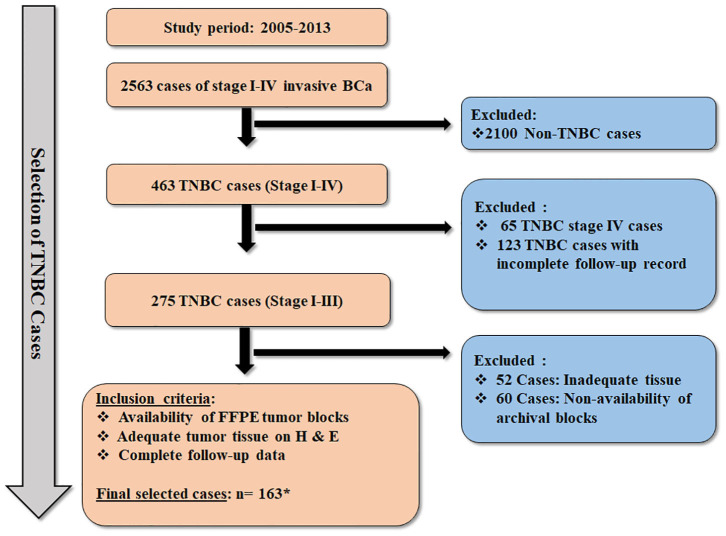
Flow diagram illustrating the selection criteria for the TNBC cases. * Thirty-four cases of TNBC were included from our previous cohort (n = 163 + 34 = 197) (18), which was evaluated for expression of AR and CSC markers. However, these 34 cases could not be further assessed for expression of CK5, CK14, nestin, Ki-67, COX2, and Bcl2 due to exhaustion of tumor tissue in FFPE blocks.